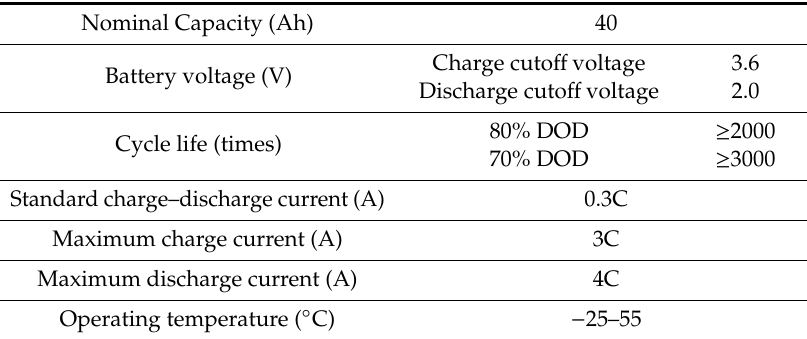
Figure 8. Battery test platform. Table 3. Parameters of the lithium iron phosphate battery.